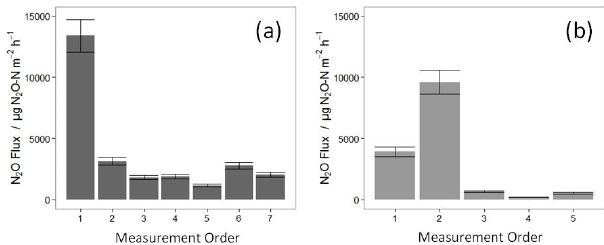
Figure 2. Fifty flux measurements of N 2 O were made on grazed grassland: the sampled locations which contained visible sheep droppings are represented by the darker bars. Error bars represent the uncertainty in each flux measurement which was calculated us- ing a propagation of regression, volume, temperature and pressure uncertainties (See Cowan et al., 2014).